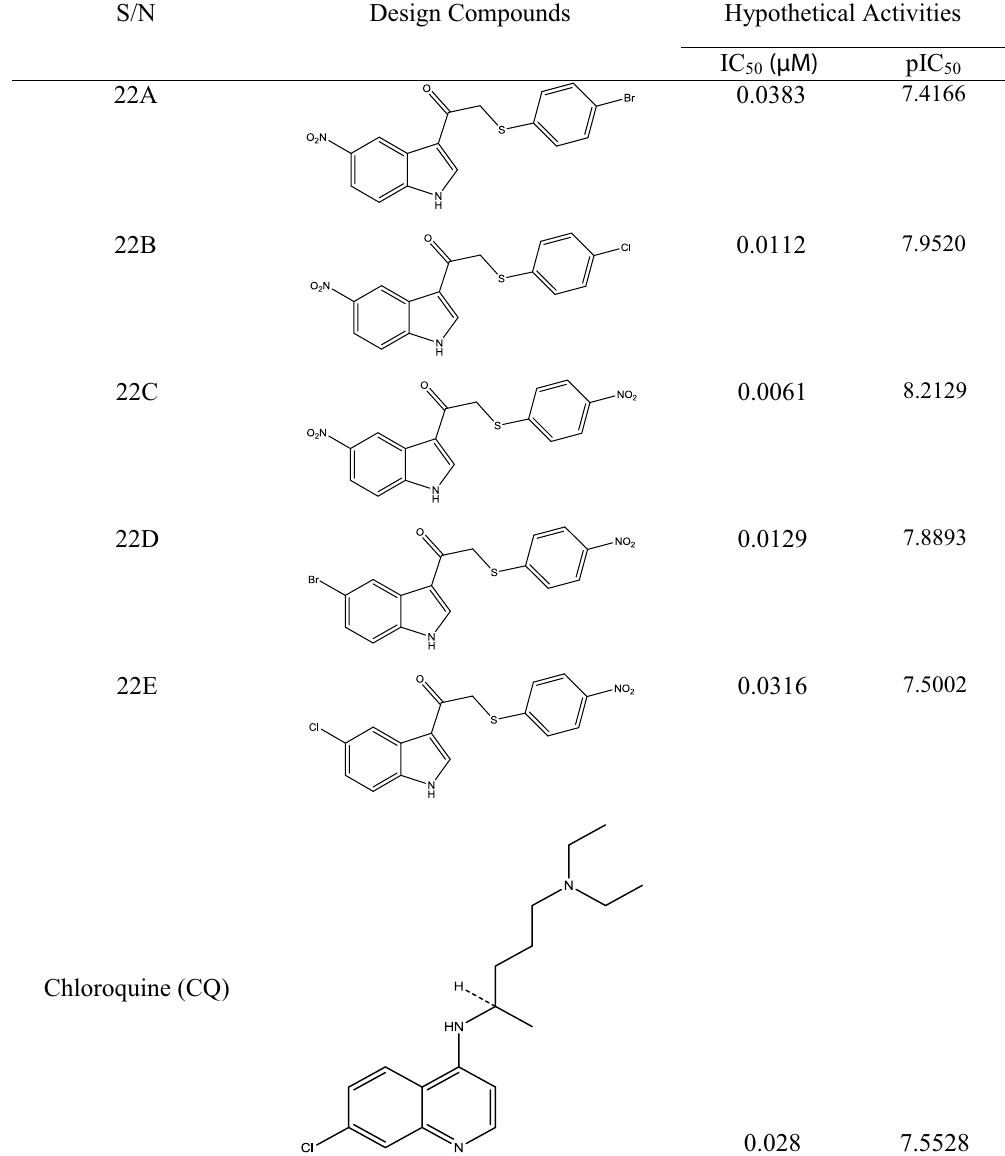
Table 4 Molecular structures of design indolyl-3-ethanone-α-thioethers derivatives and their hypothetical